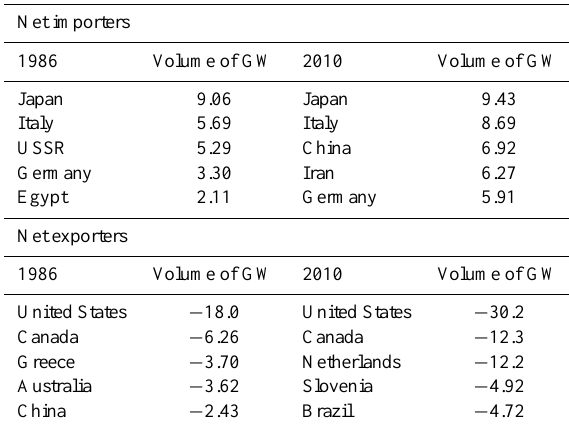
Table 2. Top net importers and net exporters of grey water (billion m 3 yr − 1 ) in 1986 and